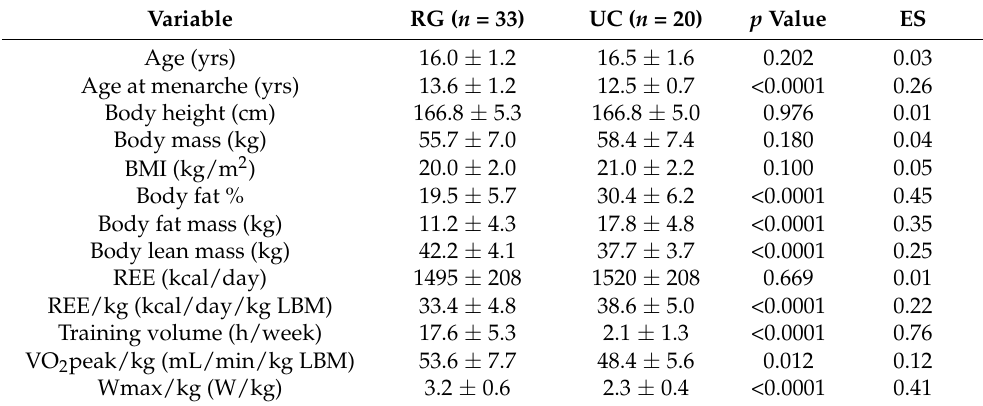
Table 1. Body composition and energy metabolism values (mean ± SD) in rhythmic gymnasts (RG) and untrained controls (UC).